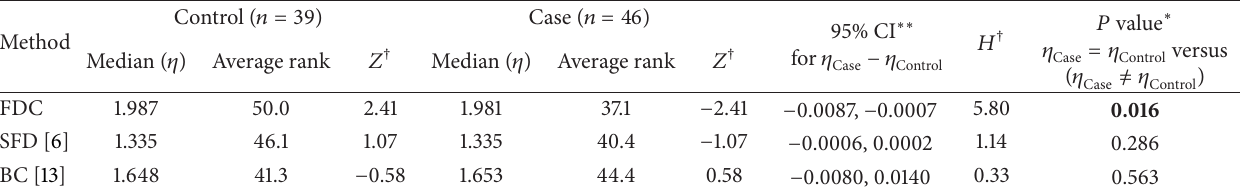
Table 2: Nonparametric Kruskal-Wallis and Mann-Whitney significance test between control and case groups on retinal images.